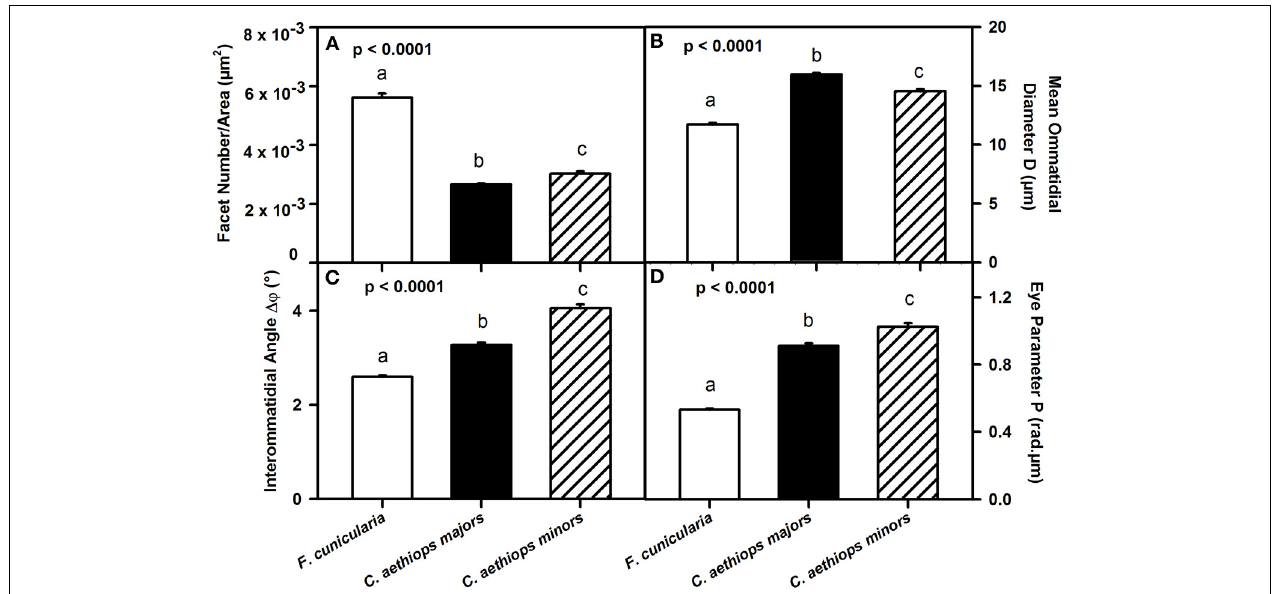
FIGURE 4 | Comparative analysis of eye parameters between F. cunicularia and C. aethiops majors and minors. Different letters indicate significant differences. (A) Number of ommatidial facets per area ( μ m 2 ) of compound eye, which provides an estimate of compound eye resolution. F. cunicularia exhibited significantly more facets per unit area of compound eye than both C. aethiops major and minors ( p < 0 . 001 for both comparisons); C. aethiops minors had in turn a significantly higher number of facets per unit area than majors ( p < 0 . 05). (B) Facet diameter (D) ( μ m) differed significantly between the three groups of ants. It was smaller in F. cunicularia , intermediate in C. aethiops minors and larger in C. aethiops majors. All values